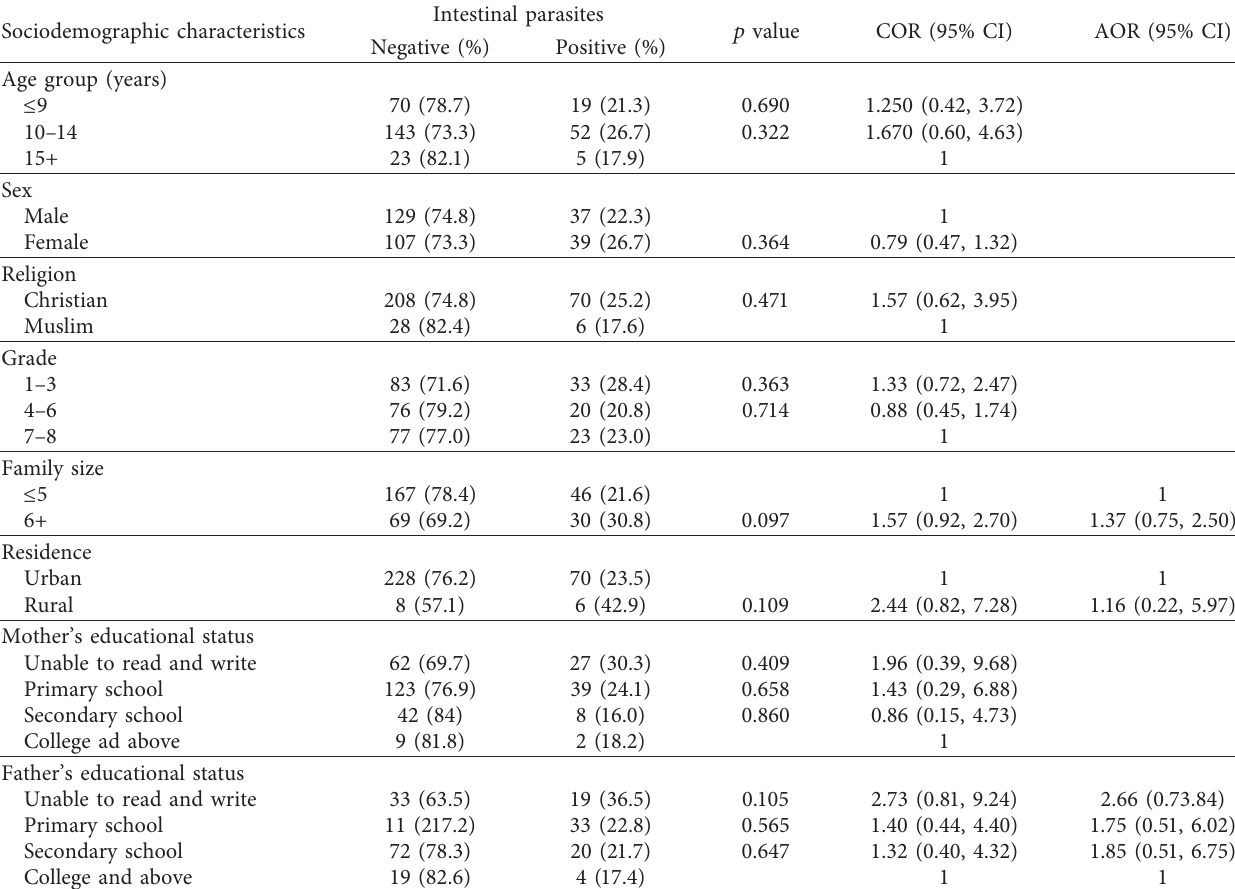
Table 3: Prevalence of intestinal parasitic infection stratified by sociodemographic characteristics among schoolchildren in two primary school children in Rama town, Northern Ethiopia, June 2017. Sociodemographic